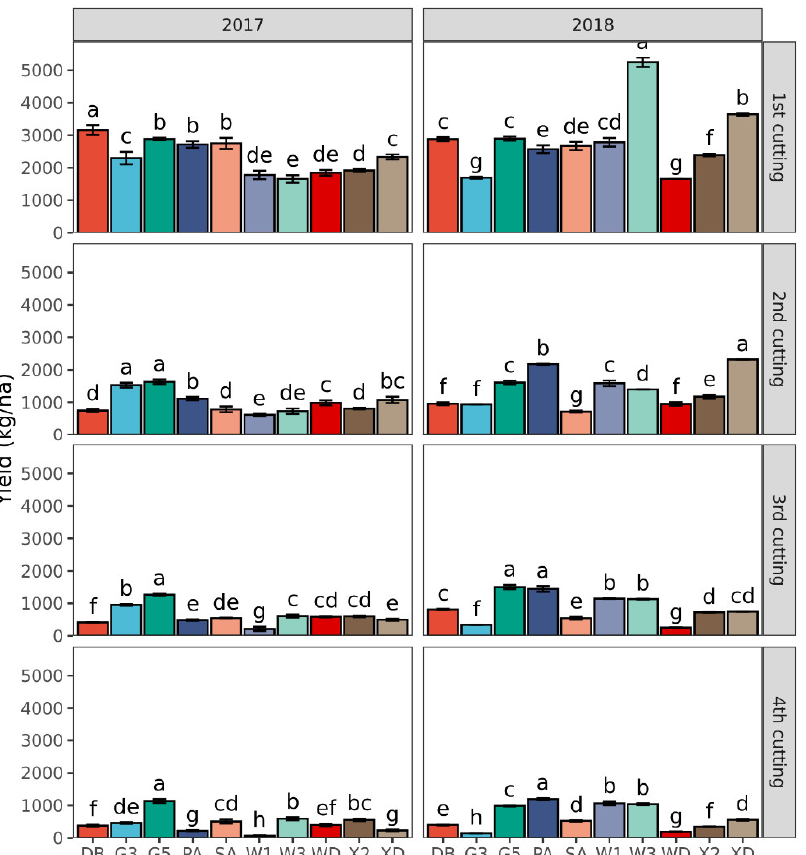
Figure 3. Forage yield for each cutting (1st to 4th) of 10 alfalfa varieties in 2017 and 2018. Different letters indicate means that are significantly different at p < 0.05. Error bars indicate the standard deviation of the means. DB: Derby, G3: Gannong No. 3, G5: Gannong No. 5, PA: Phabulous, SA: Sanditi, W1: WL168HQ, W3: WL343HQ, WD: Wudi, X2: Xinmu No. 2, XD: Xinjiang Daye.